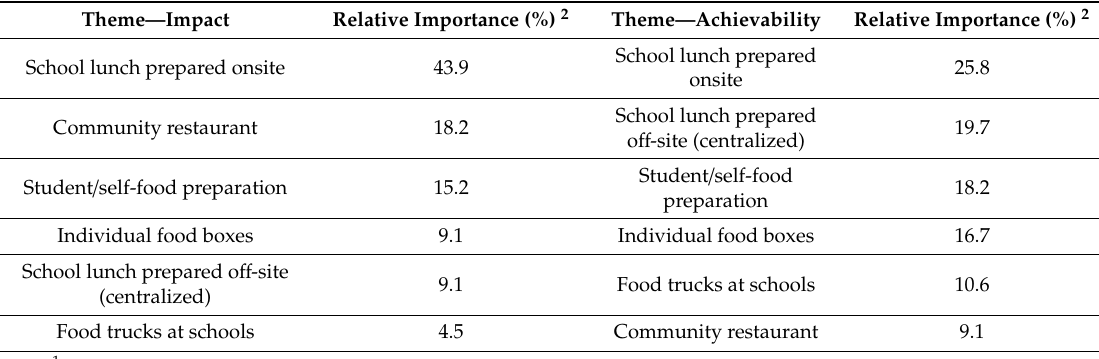
Table 2. Prioritized and ranked 1 food provision models from the consensus